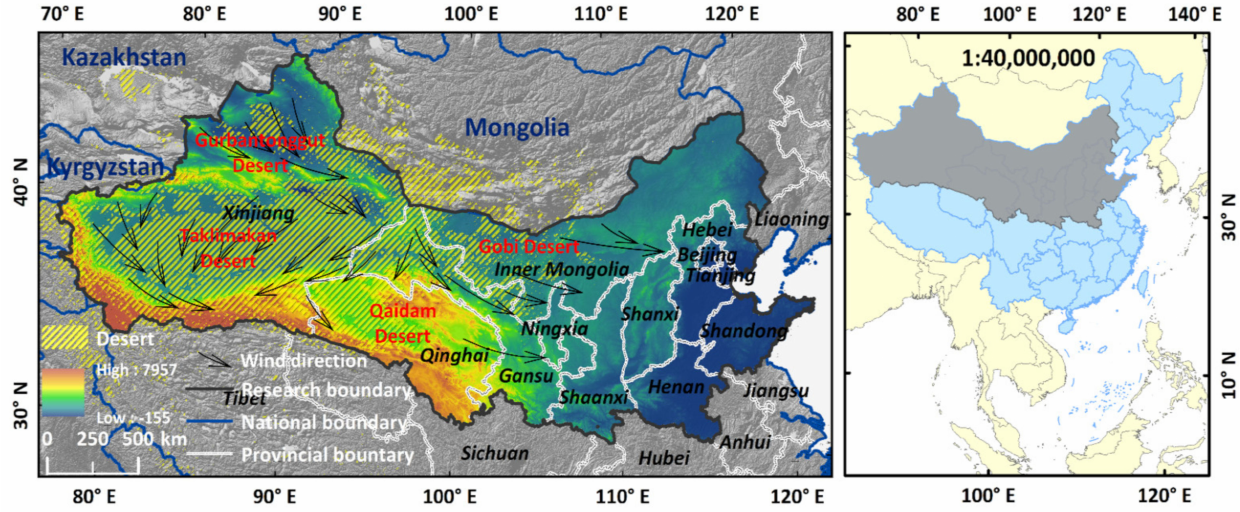
Figure 1. Location of northern China. There are four major dust sources in northern China: (1) the Taklimakan Desert, located in the central area of the Tarim Basin in southern Xinjiang, with an area of approximately 330,000 km 2 , which is the largest desert in China; (2) the Gobi Desert, located between Xilin Gol (Inner Mongolia) and Mongolia, with a total area of 1,300,000 km 2 ; (3) the Gurbantunggut Desert, located in the center of the Junggar Basin (Xinjiang), with an area of approximately 48,800 km 2 ; and (4) the Qaidam Desert, located in the Qaidam Basin (northeast of the Qinghai-Tibet Plateau), with an area of approximately 34,900 km 2